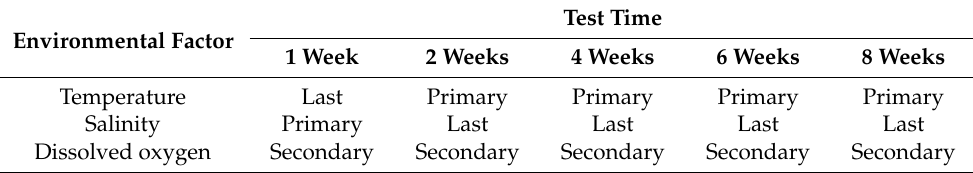
Table 9. Sensitivity of corrosion rate to environmental factors after different test